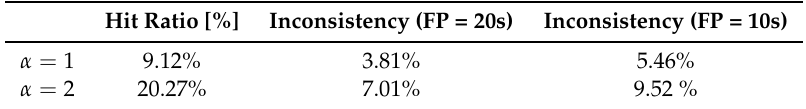
Table 2. Cache hit ratio and inconsistency metrics in presence of CEE+LRU+FP-Aware policy, when varying the Zipf skewness parameter α and the freshness period.